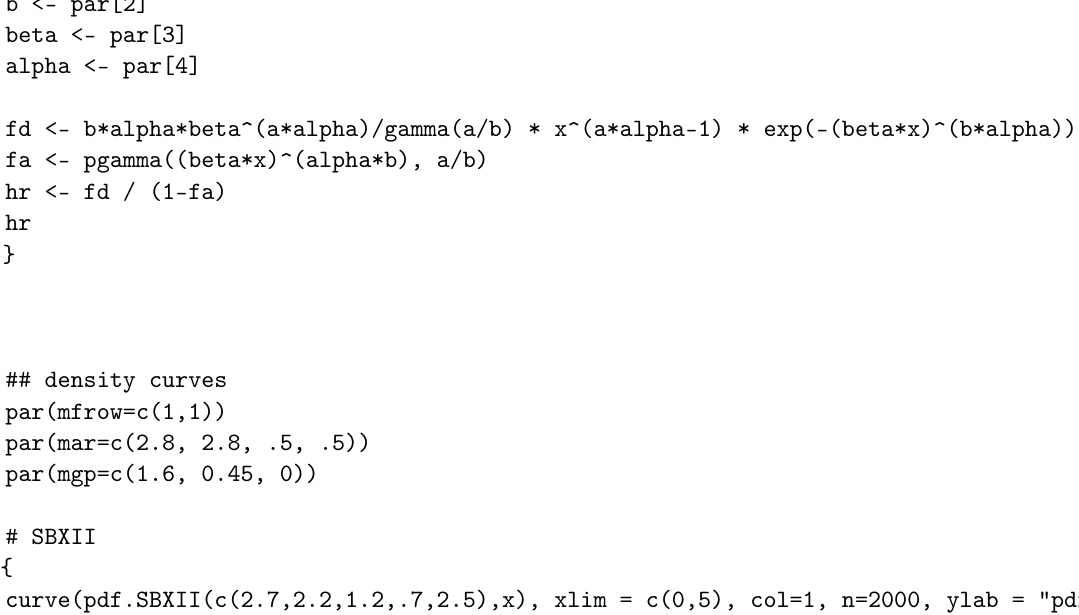
curve(pdf.SBXII(c(2.7,2.2,1.2,.7,2.5),x), xlim = c(0,5), col=1, n=2000, ylab = "pdf", lwd=1.5,